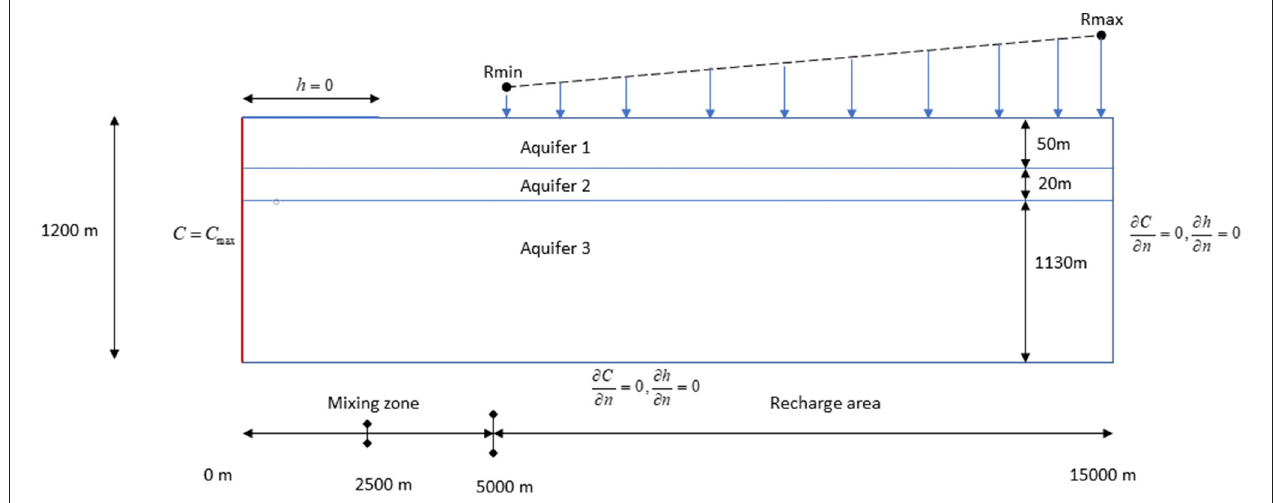
FIGURE 2 | Conceptual model of the 2D VDST numerical